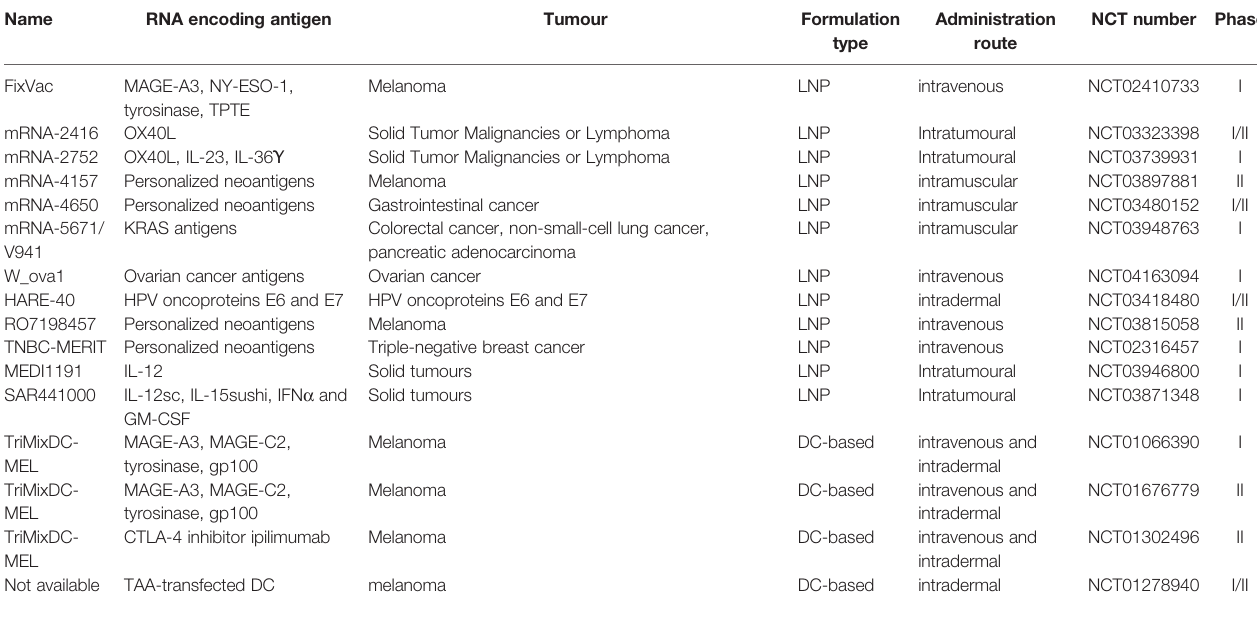
TABLE 1 | Representative clinical trials of LNP-based and DC-based mRNA cancer